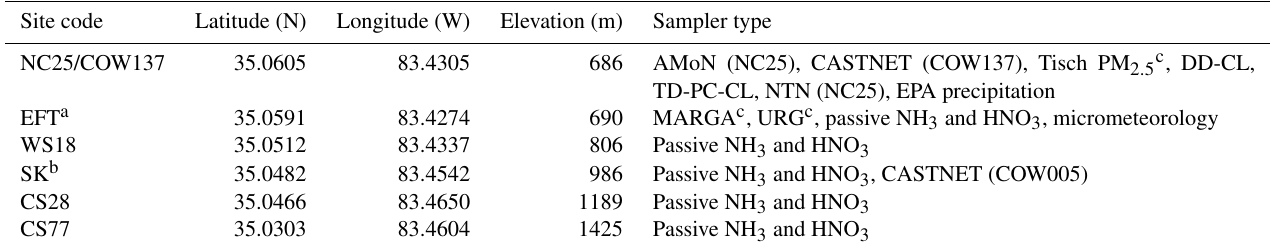
Table 1. Sampling locations and type of sampler deployed.